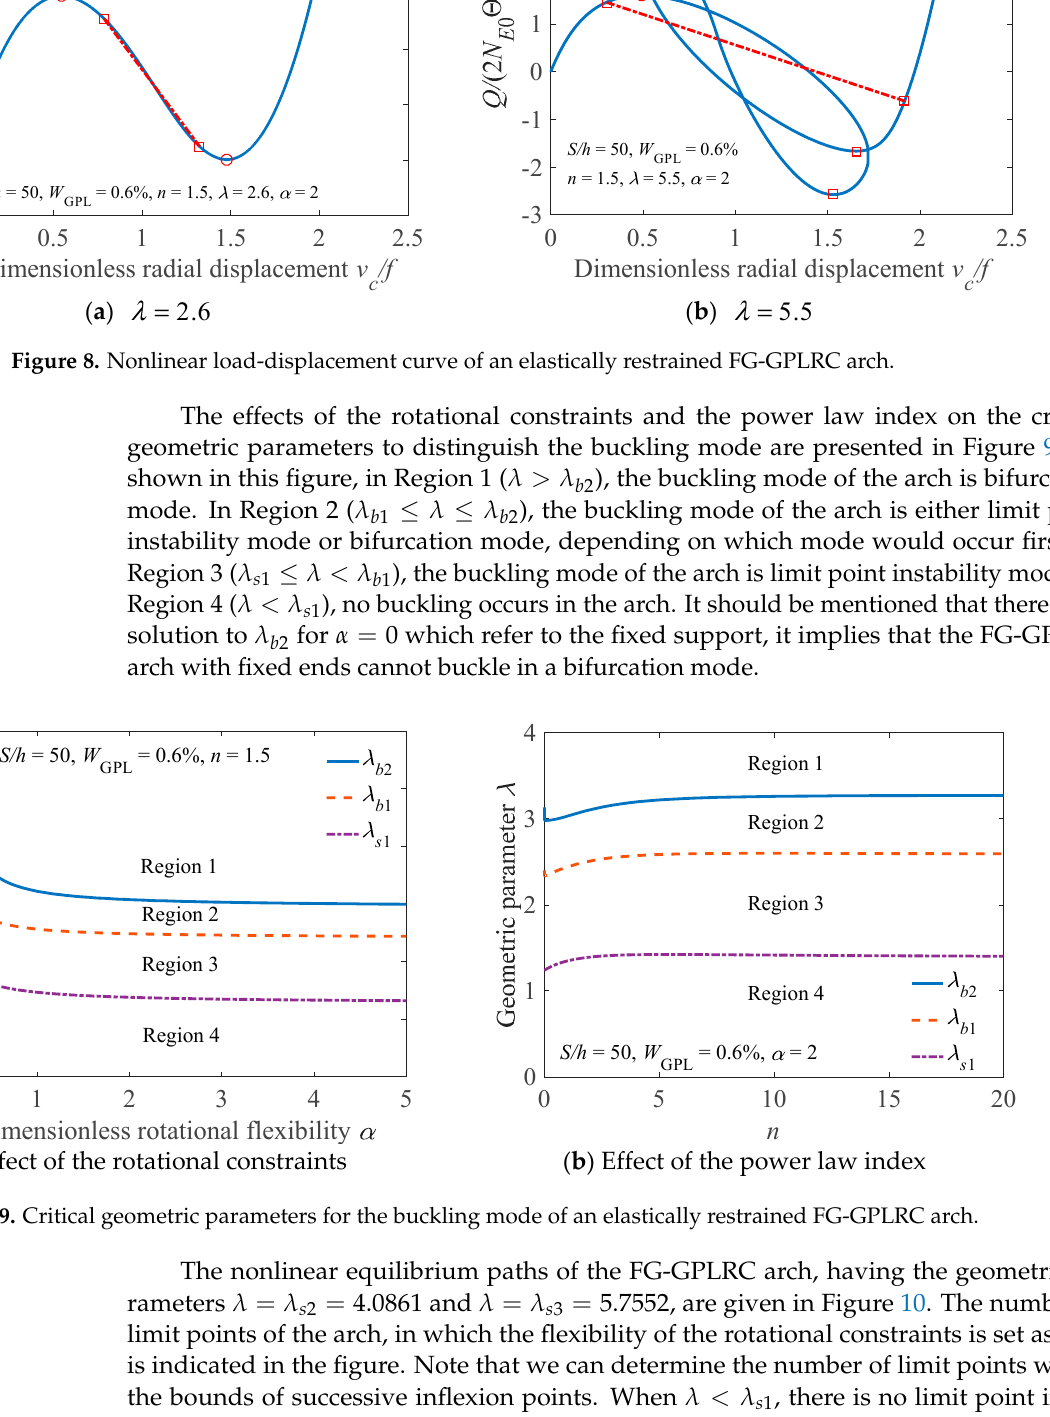
The nonlinear equilibrium paths of the FG-GPLRC arch, having the geometric pa- rameters λ = λ s 2 = 4.0861 and λ = λ s 3 = 5.7552, are given in Figure 10. The number of limit points of the arch, in which the flexibility of the rotational constraints is set as two, is indicated in the figure. Note that we can determine the number of limit points within the bounds of successive inflexion points. When λ < λ s 1 , there is no limit point in the nonlinear equilibrium path. When λ s 1 < λ < λ s 2 , there are two limit points in the non- linear equilibrium path. When λ s 2 < λ < λ s 3 , there are four limit points in the nonlinear equilibrium path, and so on. Hence, the first 18 limit points and the corresponding critical geometric parameters λ sn of the arch with the power law index n = 1.5 and n = 3 are plotted in Figure 11 for further clarification.